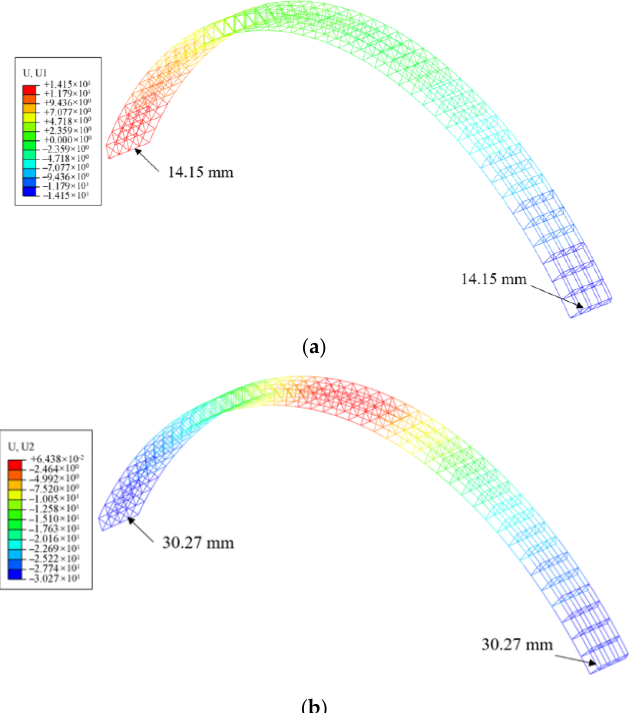
Figure 19. Deformation nephograms of the spatial reticulated grid. ( a ) Transverse deformation and ( b ) vertical deformation. (2) 1/3 position